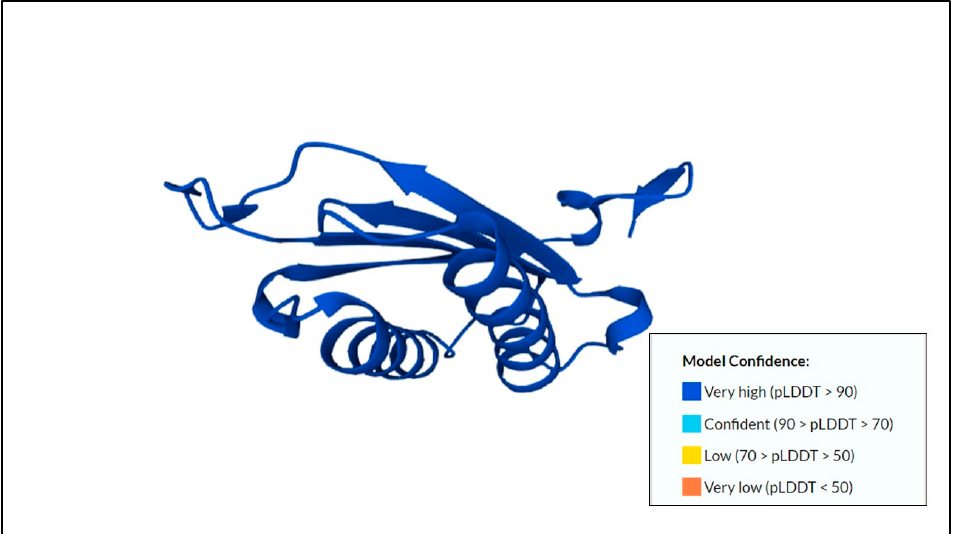
Figure 6. Predicted protein structure of migration inhibitory factor (EhMIF) [41,80,83] (https://www.uniprot.org/uniprotkb/A0A5K1URL6/entry, accessed on 25 October 2022).